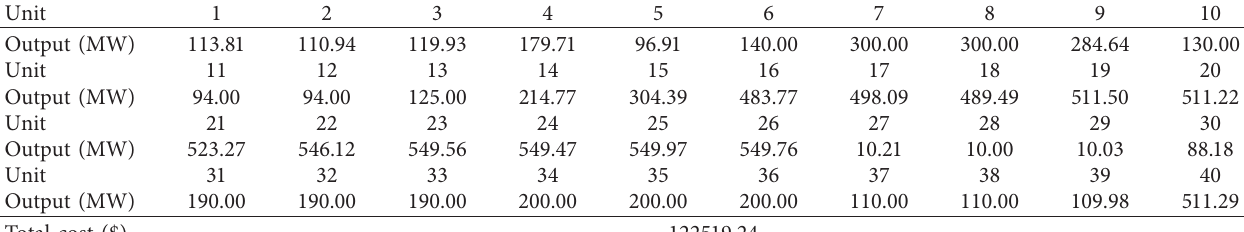
Table 9: Best dispatch obtained by ISSO for 40-unit system with P